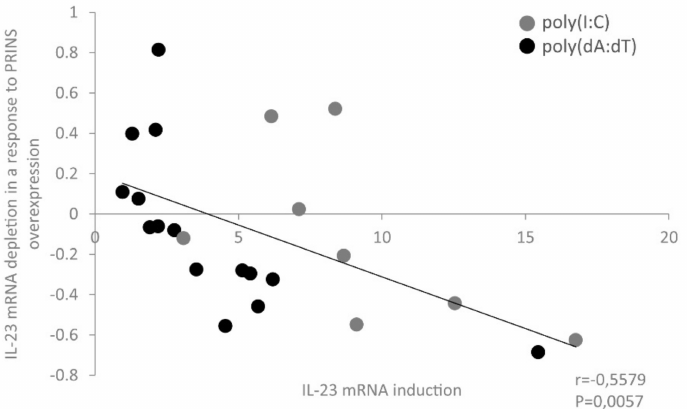
Figure 10. Analysis of the association between nucleic-acid-induced IL-23 mRNA abundance and the effect of PRINS overexpression on it shows a significant moderate negative correlation. The IL-23 mRNA depletion was determined as the relative change of PRINS-overexpressing samples compared to pcDNA3.1-transfected samples and displayed as a function of the poly(I:C)- or poly(dA:dT)- induced IL-23 mRNA expression of each